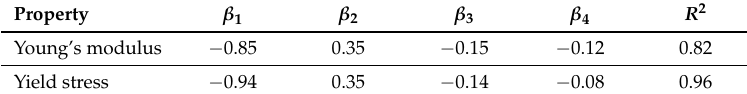
Table 3. Bayesian updating for model y = β 1 x 1 + β 2 x 2 + β 3 x 2